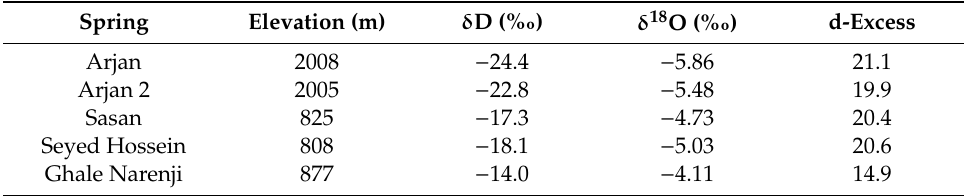
Table 1. Results of stable isotope